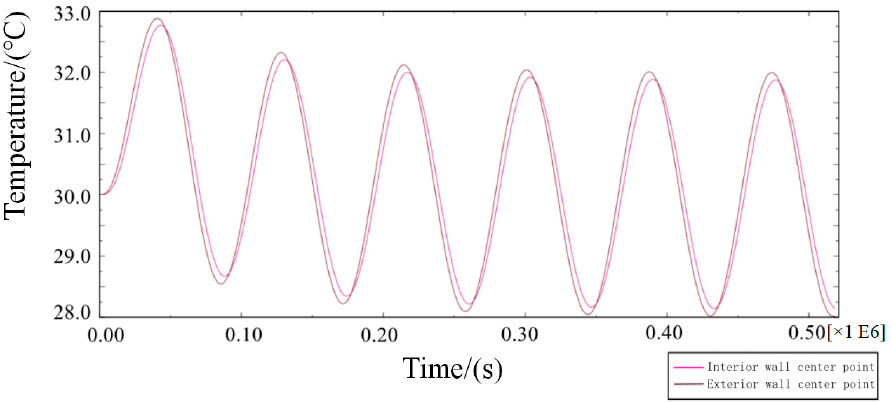
Figure 9. Six-cycle transient heat transfer characteristic point temperature curve.